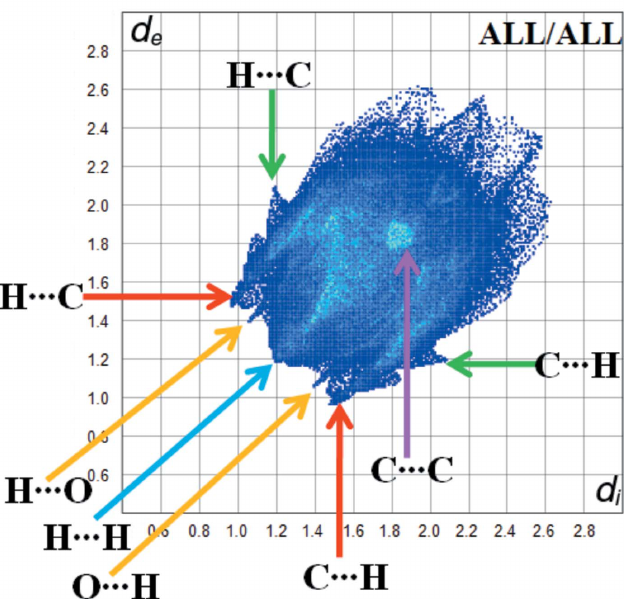
Figure 5 Fingerprint plot for the title compound.